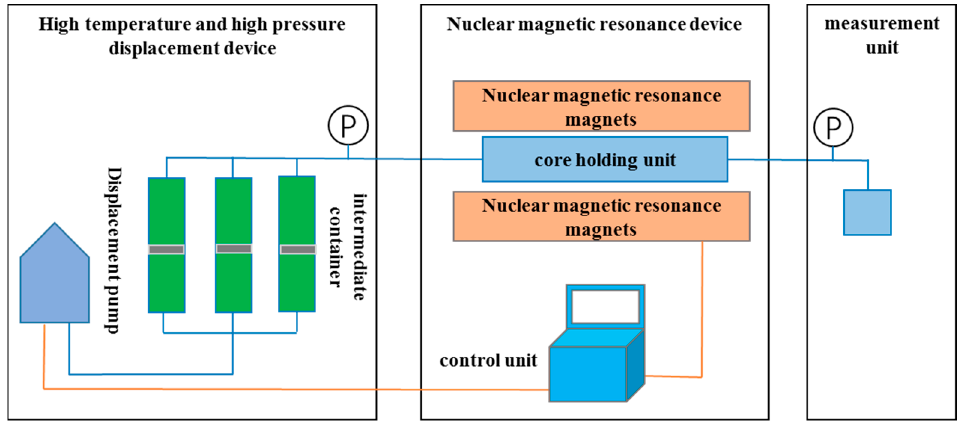
Figure 2. Schematic diagram of low-field nuclear magnetic resonance displacement device.